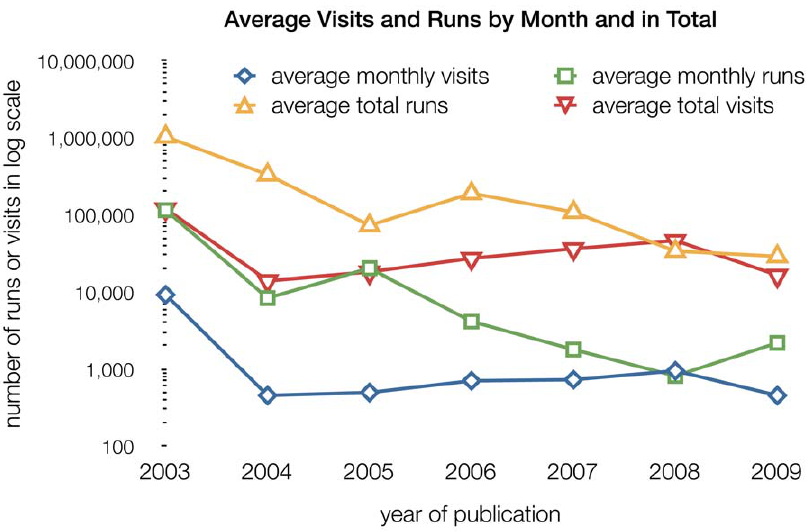
Figure 2. Average number of visits to the Web services and average runs, both by month and in total, in log scale. There is a clear exception for services in the 2003 issue, visible in the number of runs per month: These services are still heavily used and have amassed a very high visitor and run total. 157 of 274 respondents (57%) answered the question about monthly data and 137 (50%) also stated total estimates. The blue, diamond-shaped symbols illustrate how newer services usually have a higher number of monthly visits, declining over time as the services become used less frequently. With the exception of the 2008 average, visitors also seem to use services more than once per visit. This is reflected both in the monthly and in the total